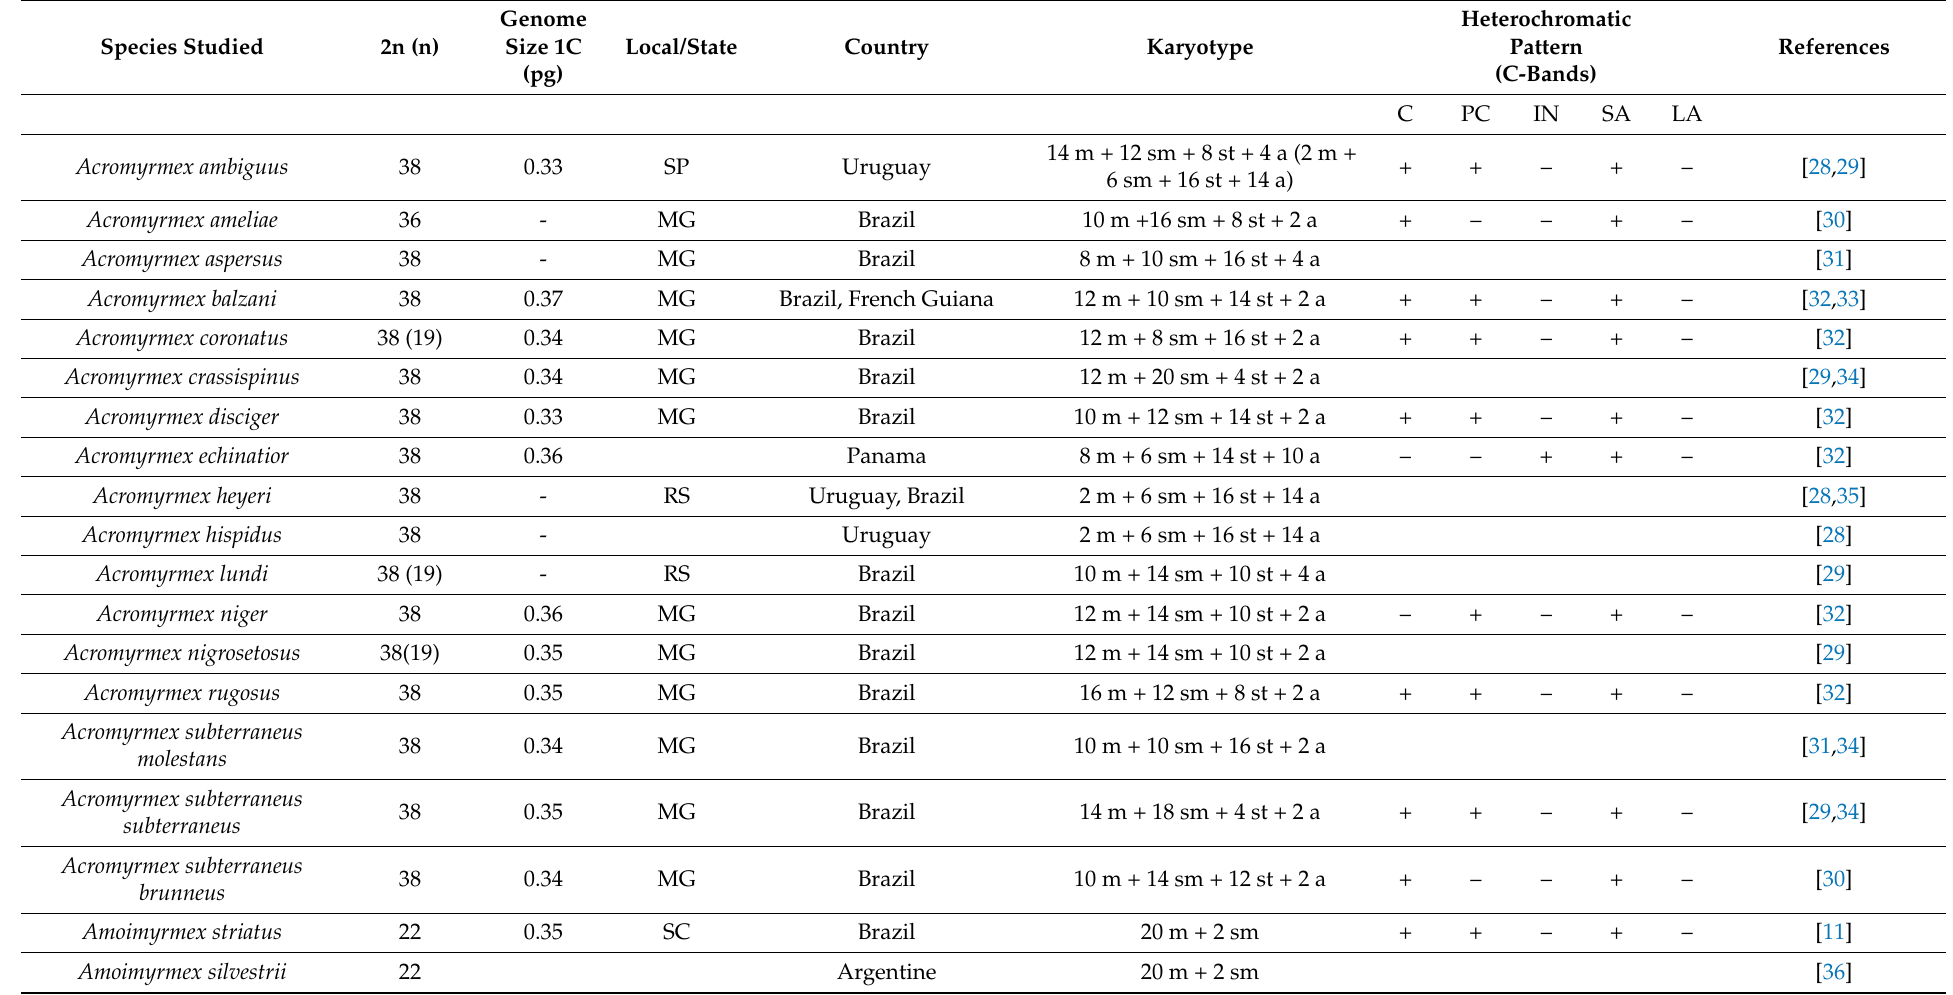
Table 5. Fungus-farming ants cytogenetically studied to date and the new reports from the present study. The heterochromatic pattern evidenced by C-band technique, karyotype structure (formula), and genome size is